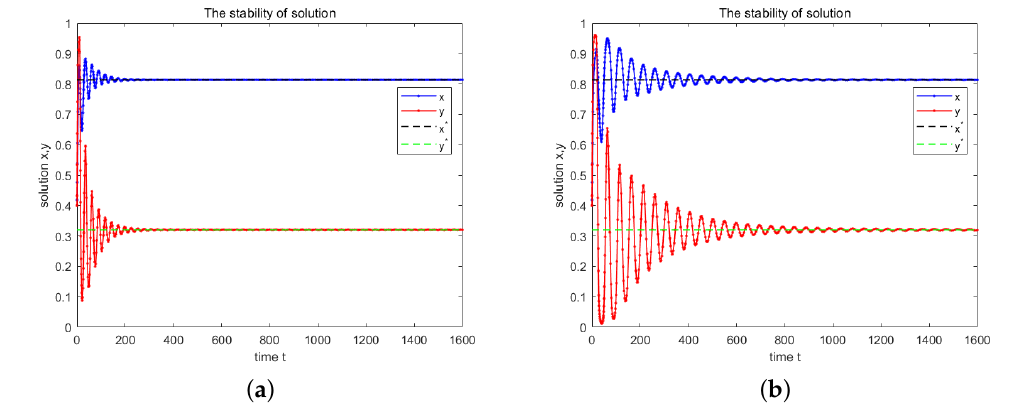
Figure 4. ( a ) The stability of the mixed ESS with four delays τ 1 = 9, τ 2 = 10, τ 3 = 11, τ 4 = 12 time units. ( b ) The stability of the mixed ESS with four delays τ 1 = 18, τ 2 = 20, τ 3 = 22, τ 4 = 24 time units where p 0 = 0.5, p 1 = 0.2, p 2 = 0.15, p 3 = 0.1, p 4 = 0.05, q 0 = 0.5, q 1 = 0.1, q 2 = 0.1, q 3 = 0.1, q 4 =